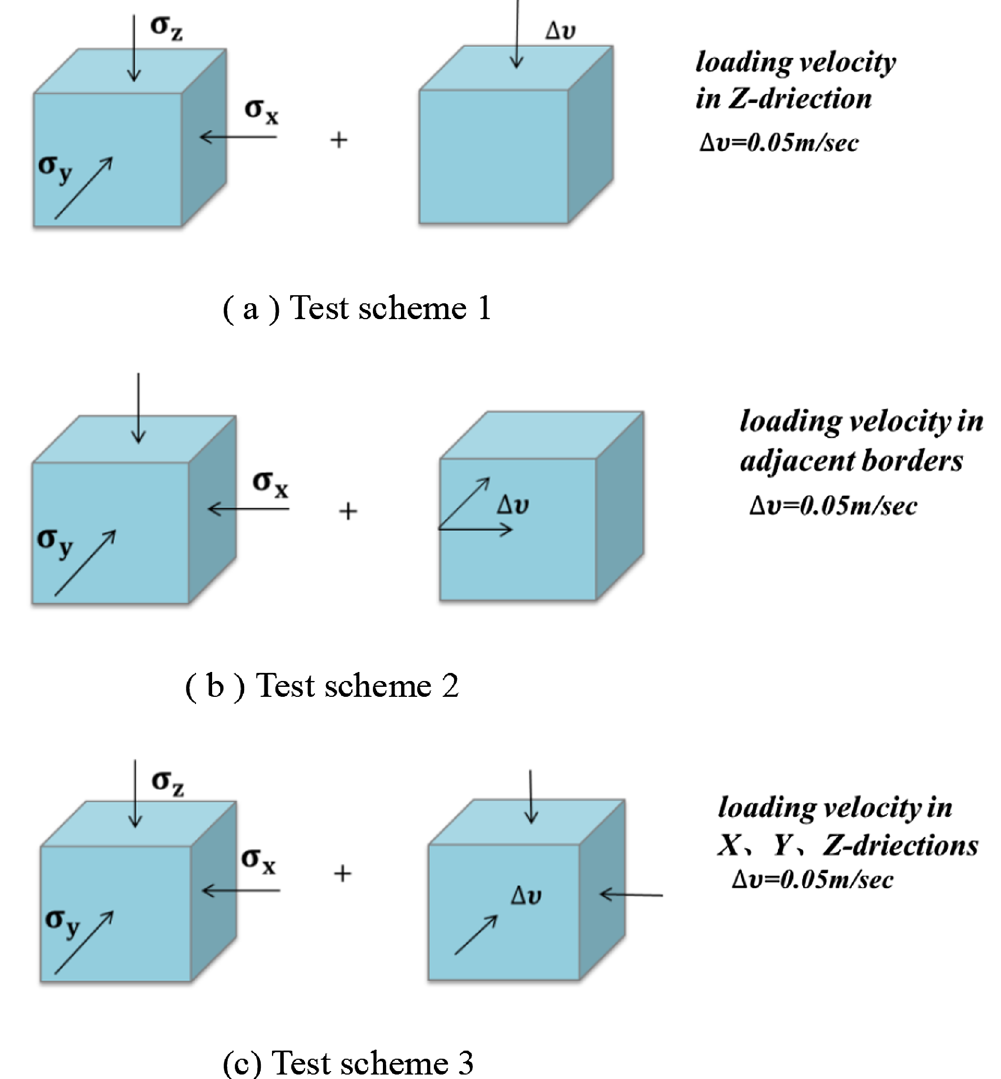
Fig. 7 Schematic diagram of the numerical test (Wu and Kulatilake 2012)